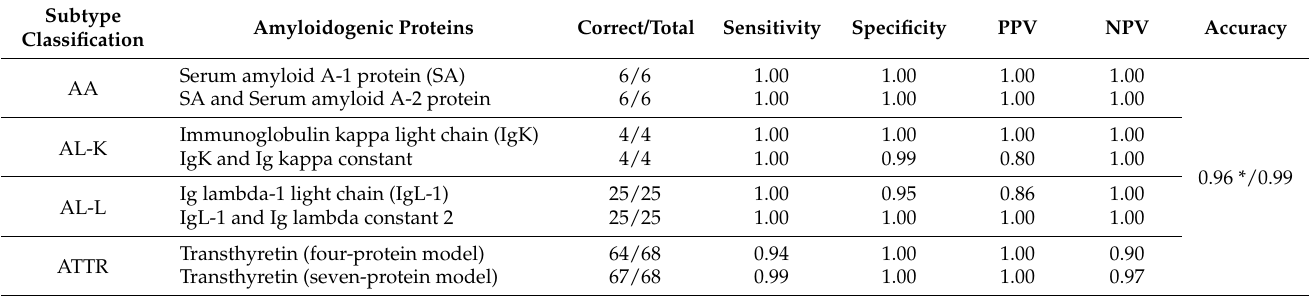
Table 5. SVM-based classification of prospectively collected amyloid-containing samples. The validation set consisted of 103 Congo positive cases with confirmed diagnosis by IEM. In total, 69 ATTR cases, 21 AL-L cases and 4 AL-K was included in the validation set. For the 4-protein model, four ATTR-cases were misclassified as AL-L, whereas for the 7-protein model one ATTR sample was misclassified as